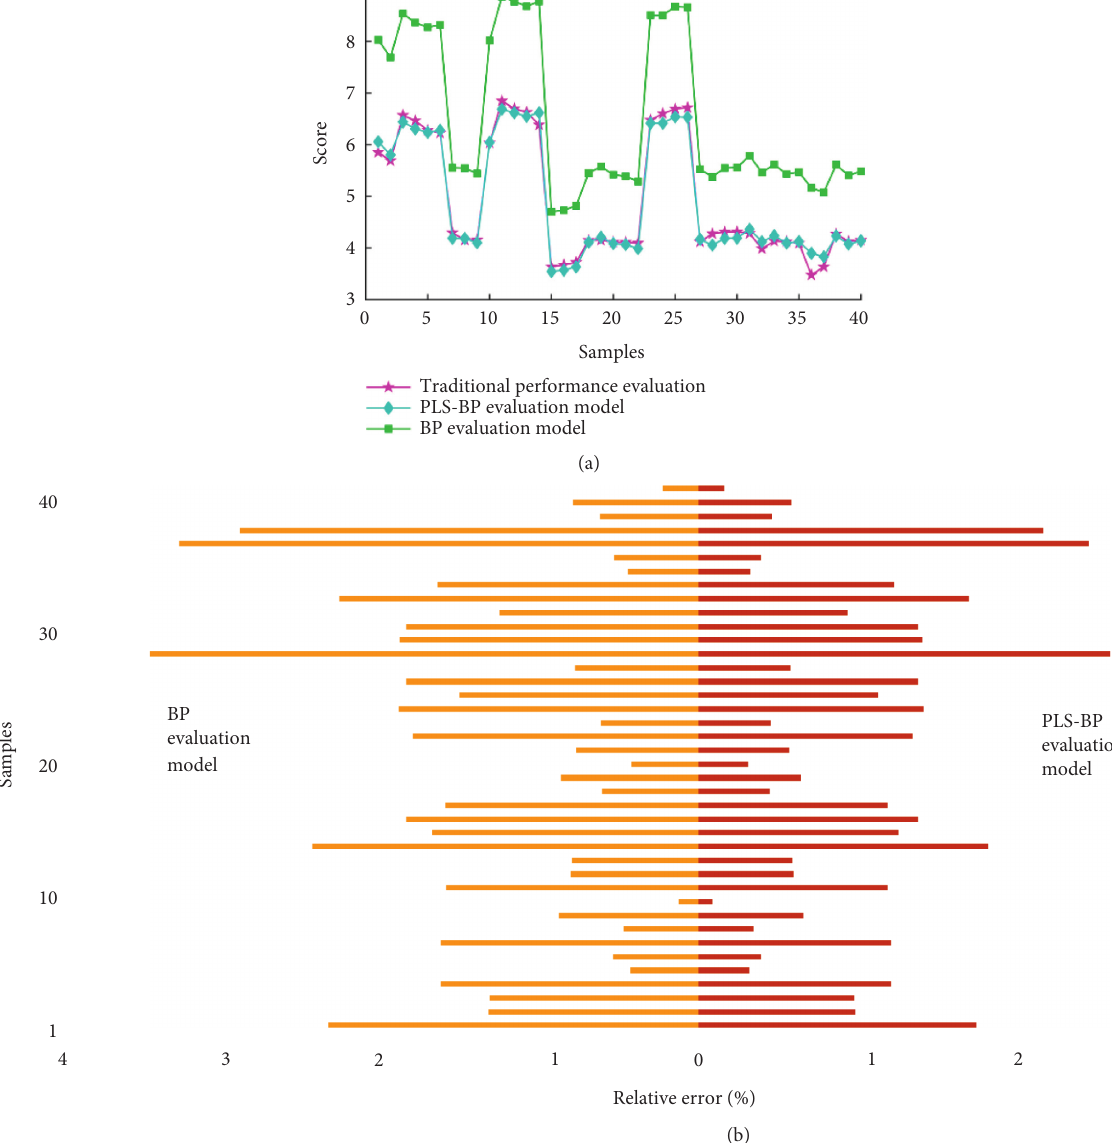
Figure 5: Comparison results of performance score: (a) scores; (b) relative